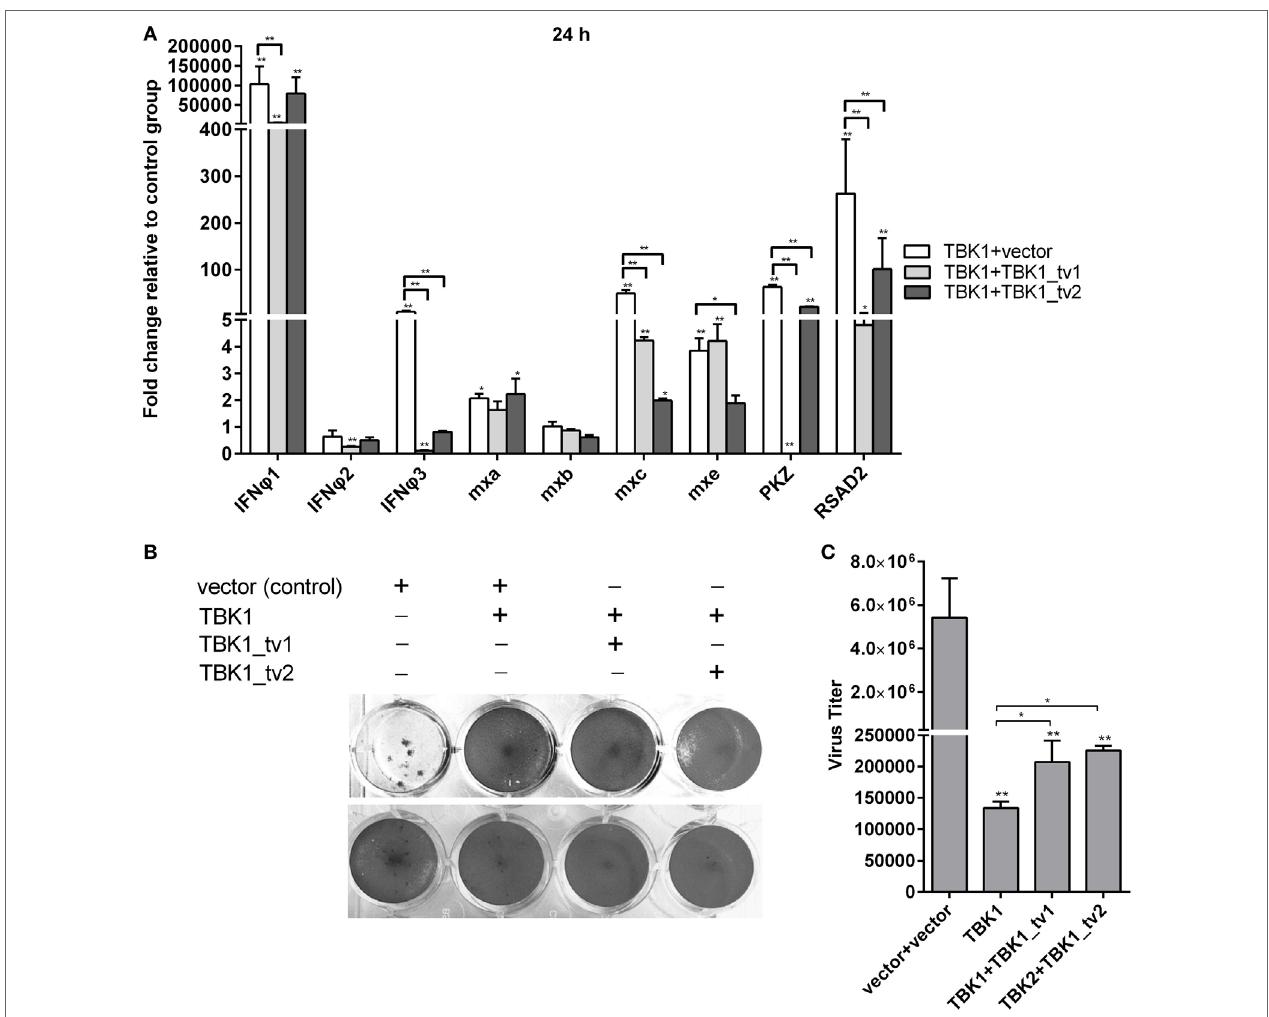
FigUre 5 | TANK-binding kinase 1 (TBK1) isoforms are negative regulators for TBK1-mediated innate immunity. (a) Effects of zebrafish TBK1_tv1 and TBK1_tv2 isoforms on the expression of interferons (IFNs) and IFN-stimulated genes induced by TBK1. Embryos were microinjected at the one-cell stage with 100 ng of indicated expression construct. At 24 h postfertilization, 15 embryos for each sample were used for RNA extraction. The p3xFLAG-injected group was used for control. Data were expressed as mean ± SEM of three independent experiments. * p < 0.05, ** p < 0.01. (B) Effects of zebrafish TBK1_tv1 and TBK1_tv2 isoforms on antiviral activity mediated by TBK1. The upper panels were transfected cells with spring viremia of carp virus (SVCV) infection. The lower panels were transfected cells without infection. (c) Effects of zebrafish TBK1_tv1 and TBK1_tv2 isoforms on SVCV replication mediated by TBK1. Epithelioma papulosum cyprini cells seeded overnight in 24-well plates at 3 × 10 5 cells per well were transiently transfected with 400 ng various indicated plasmids. Thirty hours post-transfection, the cells were infected with SVCV at a multiplicity of infection of 5. Another 48 h later, the supernatants were collected for the determination of virus titers by standard plaque assay. The plates fixed in 10% paraformaldehyde for 1 h were stained with 0.5% crystal violet and photographed. Data represent mean ± SEM ( n = 3) and were tested for statistical significance. * p < 0.05, ** p <